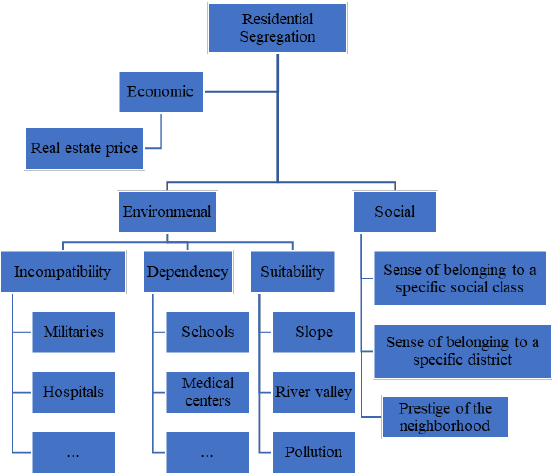
Figure 2: The hierarchy of effective factors in